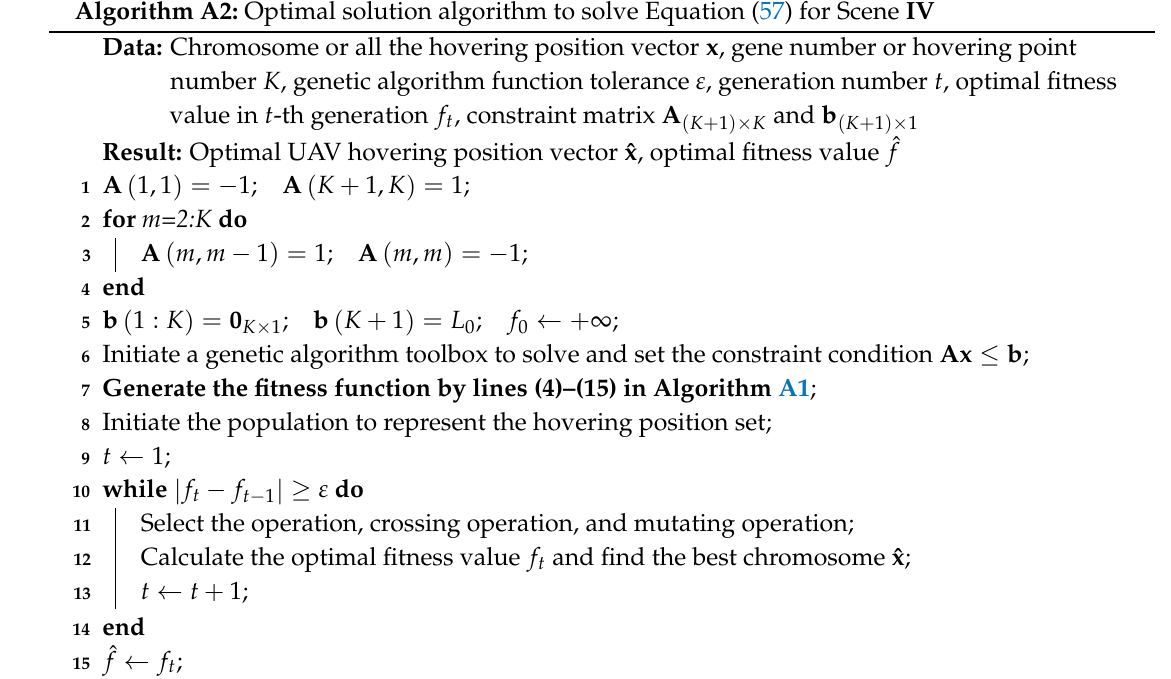
Algorithm A2: Optimal solution algorithm to solve Equation (57) for Scene IV Data: Chromosome or all the hovering position vector x , gene number or hovering point number K , genetic algorithm function tolerance ε , generation number t , optimal